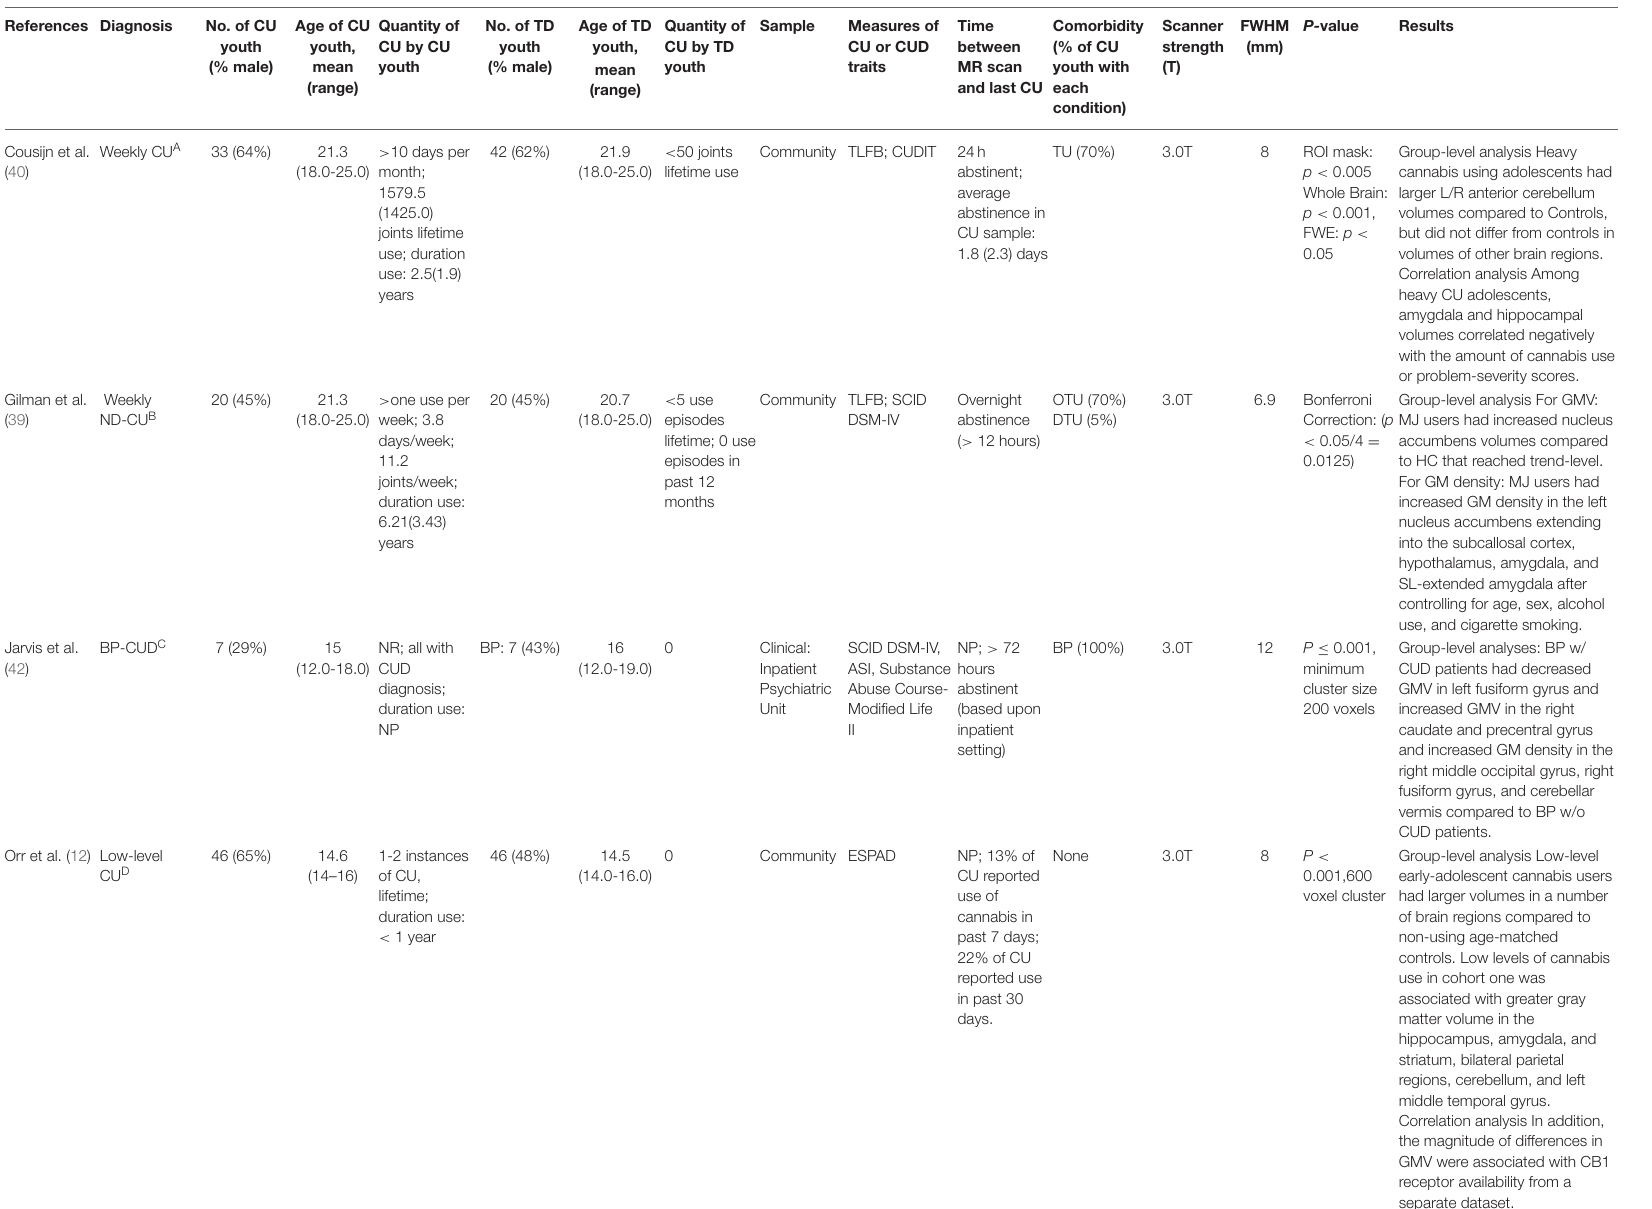
TABLE 1 | Summary of VBM studies included in the